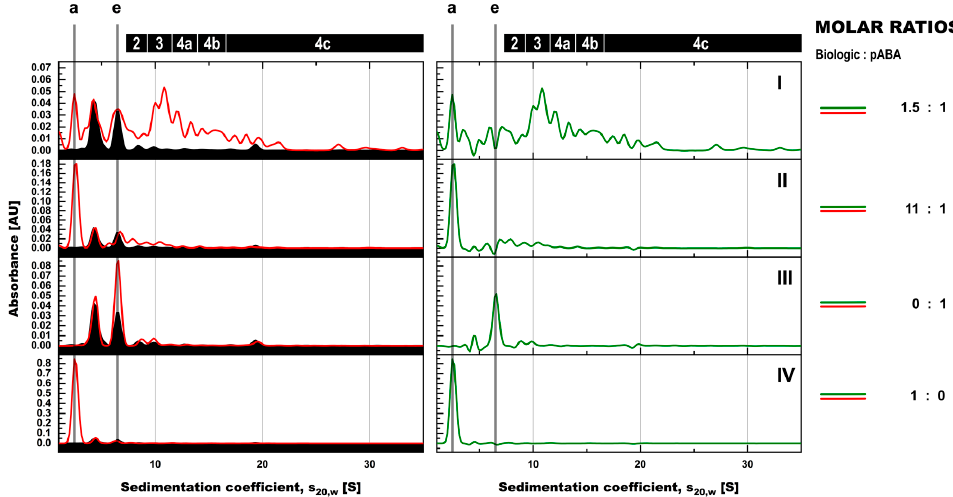
Figure 9. Assessment of immune complex formation in mouse serum background by SV-AUC. SV-AUC profiles of diluted mouse serum represented by black area under the curve and samples in diluted mouse serum by red lines (left panels), and profiles of differential representation of both after subtraction of serum matrix by green lines (right panels). Biologic:pABA compositions of the following molar ratios are shown—1.5:1 on panel ( I ), 11:1 on panel ( II ), pABA control on panel ( III ), and biologic control on panel ( IV ). Marker: (a) free biologic, (e) free pABA, (2) immune complexes with a single ABA incorporated, (3) immune complexes with two incorporated ABAs, (4a) immune complexes with three incorporated ABAs, (4b) immune complexes with four incorporated ABAs, (4c) immune complexes with more than four incorporated